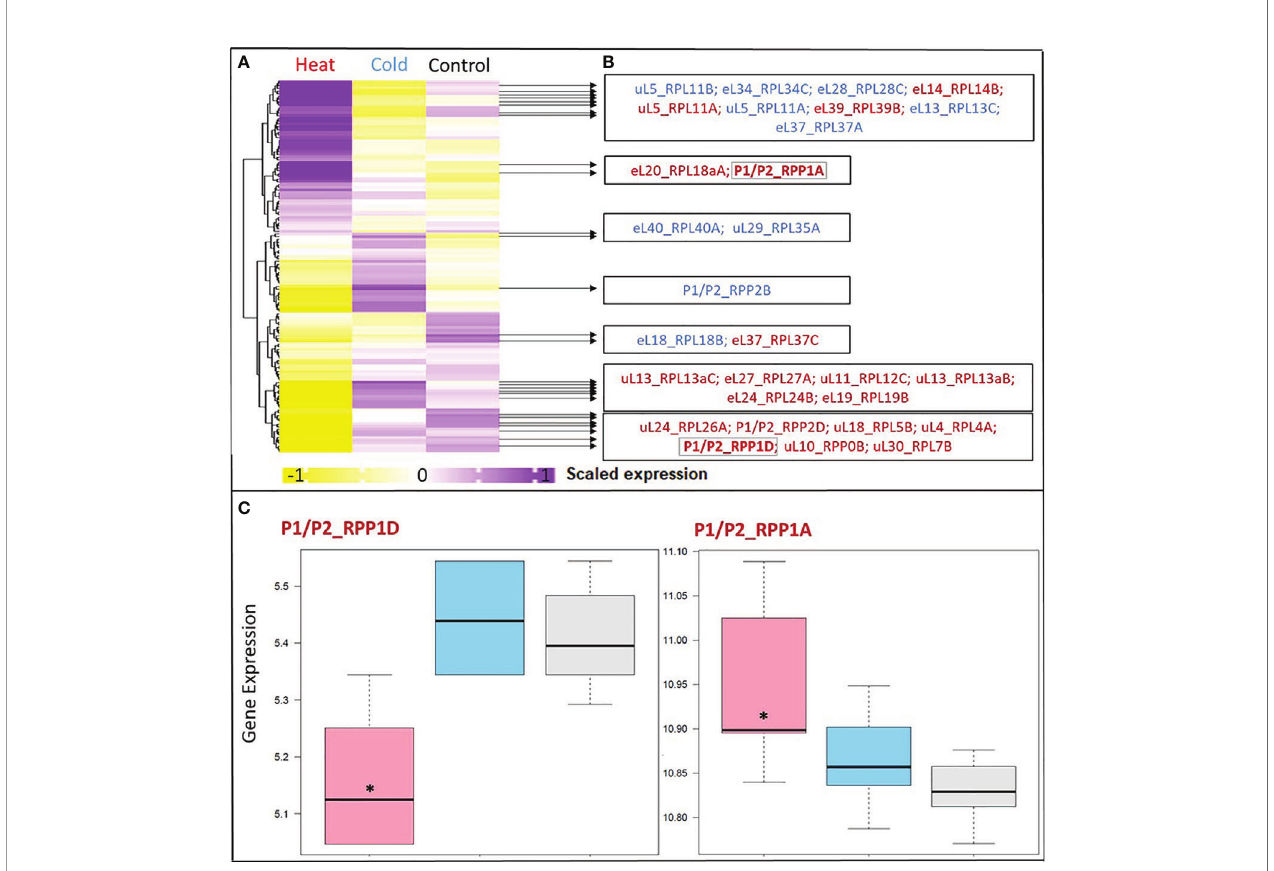
FIGURE 3 | Differential expression in response to temperature stress of Arabidopsis genes encoding structural ribosomal proteins of the 60S subunit. Expression values of 96 40S and 136 60S RPs and RP paralogs were retrieved from Genevestigator experiment AT-00120 of root tissue (n = 30) exposed to 38°C heat shock (n = 6) or 4°C cold stress (n = 12) compared to 20°C control conditions [n= 12]. Transcriptome data processing and analysis was carried out in the R programming language and environment for statistical computing, https://www.R-project.org/ (Ihaka and Gentleman, 1996), using the R project for statistical computing (RRID : SCR_001905). Gene intensities were background subtracted and quantile normalized. (A) Heatmap of autoscaled and treatment-scaled abundances ranging from -1 (yellow) to +1 (purple), mean centering was performed by the function colMeans with the R package timeSeries (version 3042.102; https://CRAN.R-project.org/ package=timeSeries). Correlation and Euclidean distance produced equivalent heatmaps due to the mode of scaling. R packages ComplexHeatmap (Gu et al., 2016), circlize (Gu et al., 2014) and fBasics (version 3042.89; https://CRAN.R-project.org/package=fBasics) were used to transform data and create the Heatmap. The statistical signi fi cance of changed gene expression relative to the control was evaluated by a generalized linear model (GLM). (B) False discovery rate (FDR)- corrected, signi fi cant temperature-responsive transcripts following heat shock (red, 20 genes) or cold stress (blue, 10 genes). One example of inversely regulated expression of two members of a single RP family, i.e., P-stalk components, during heat is highlighted in bold and by a gray outline (* in panel C ). (C) Boxplots of the highlighted inversely heat responsive transcript abundances of the P1/P2 paralogs RPP1D and RPP1A. Data are log 2 -transformed, background subtracted, quantile normalized, and